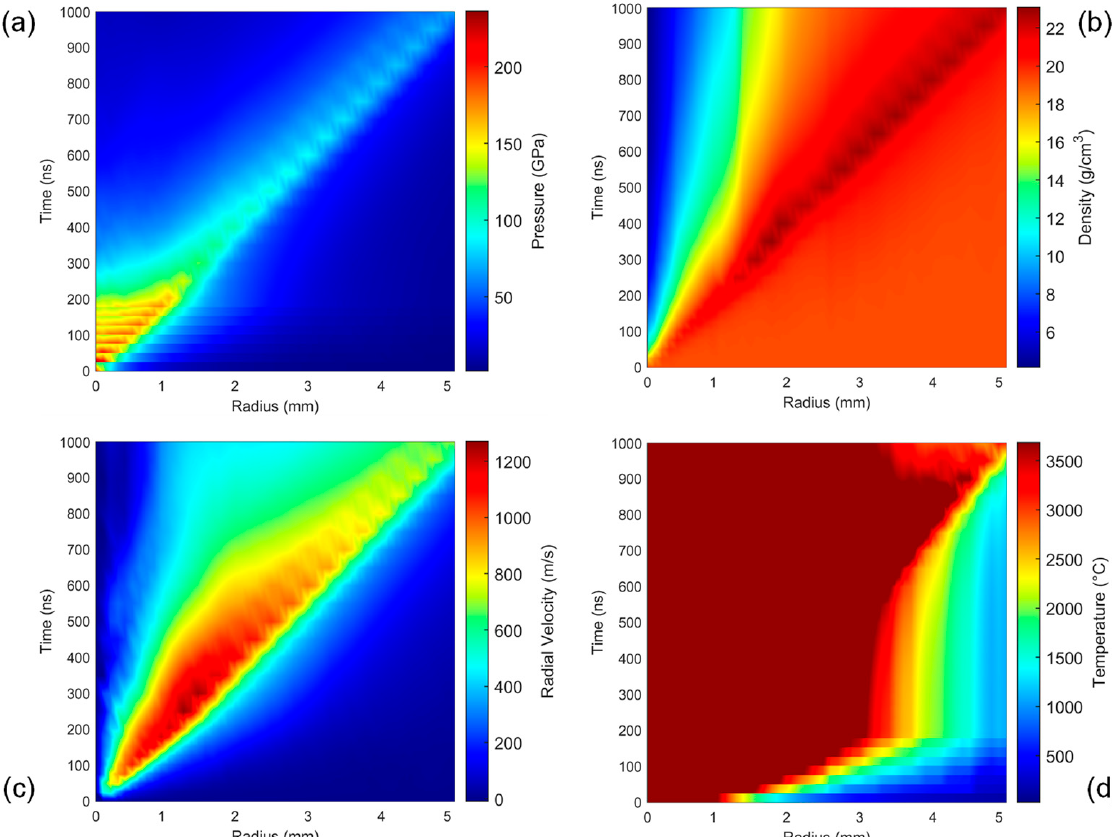
Figure 8. Pressure ( a ), density ( b ), particle velocity in radial direction ( c ), and temperature ( d ) distributions by varying the radius at the axial position of the maximum energy deposition (L Emax of Figure 5).